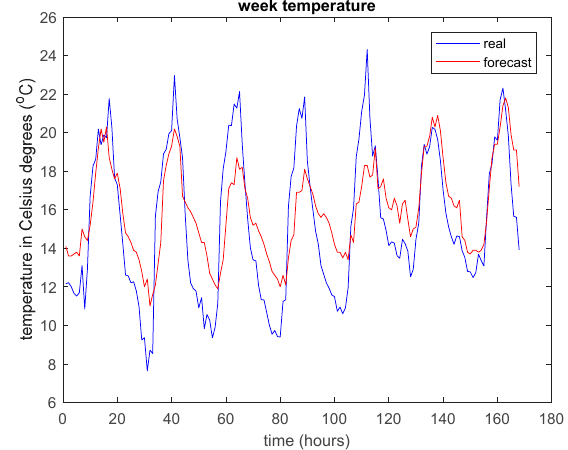
Figure 3. Weekly temperature variation used for the tests.